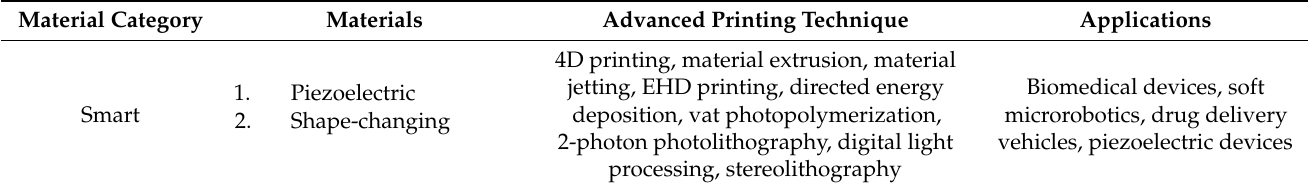
Figure 9. Classification of printable materials that can be printed in advanced printing technologies. Table 3. Summary of advanced material strategies for additive